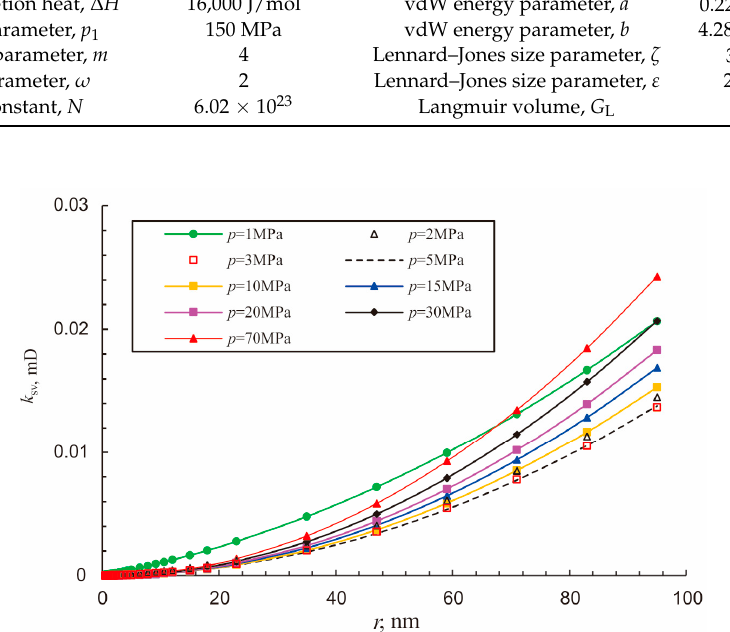
Figure 9. Equivalent permeability of slip viscous flow in different conditions.